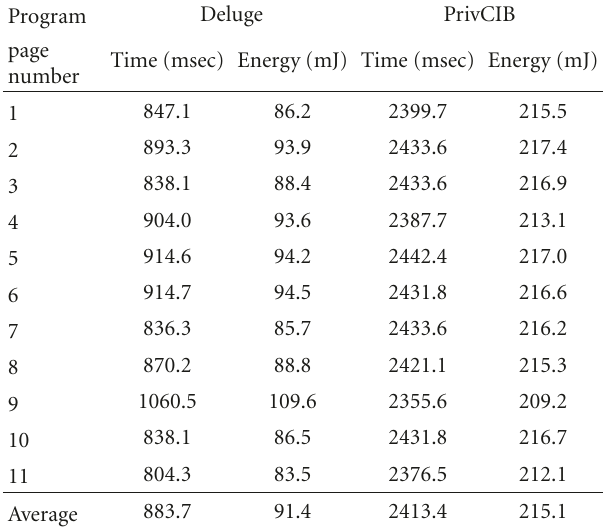
Figure 6: Power consumption trace when transfering program “Pong” using Deluge.